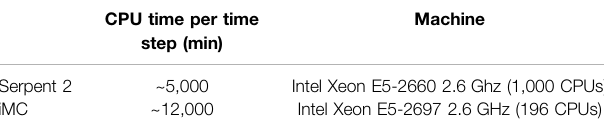
TABLE 5 | Calculation time and condition for the TMI-1 mini-core problem.